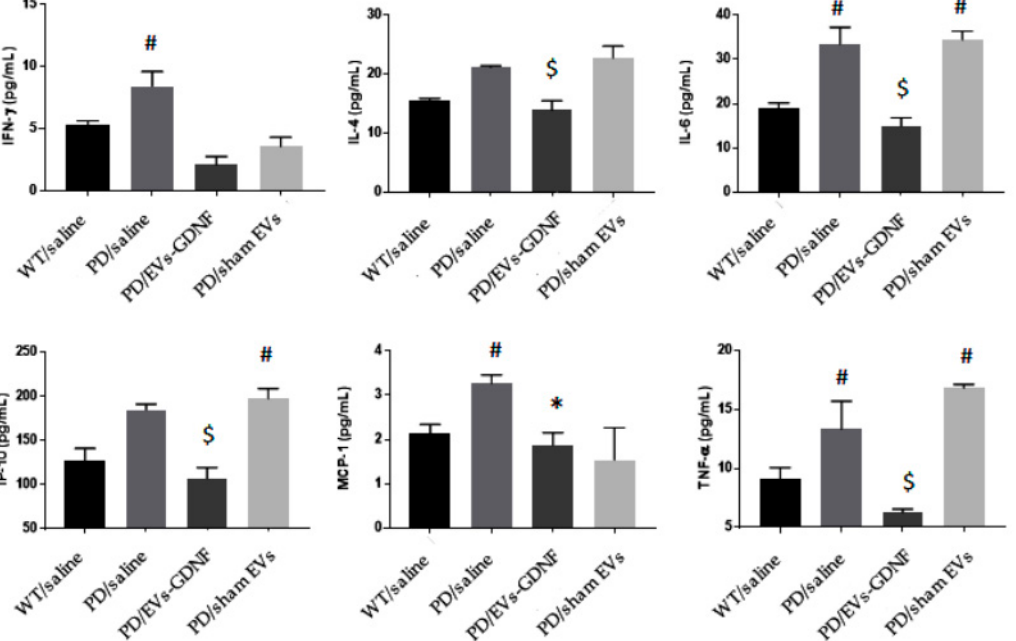
Figure 5. Anti-inflammatory effects of GDNF-carrying EVs in PD mouse model. Transgenic mice (4 mo old) were intranasally injected with: saline (10 µL/mouse), or EV-GDNF (3 × 10 9 particles/10 µL/mouse), or sham EVs (3 × 10 9 particles/10 µL/mouse). Wild-type control mice were intranasally injected with saline (10 µL/mouse). Animals were sacrificed at month 16, brains were removed post-mortem, and they were homogenized in cell lysis buffer. Elevated cytokine levels in the brain were recorded in PD mice treated with saline and sham EVs. Administration of EV-GDNF significantly decreased pro-inflammatory molecules in the brains compared with PD mice treated with saline. n = 4; # p < 0.05 compared to healthy WT animals; * p < 0.05 compared to PD mice treated with saline; $ p < 0.05 compared to PD mice treated with saline and sham EVs.